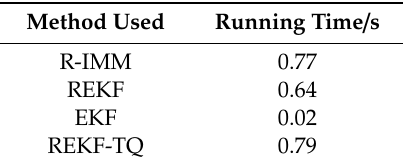
Table 5. Running time of each